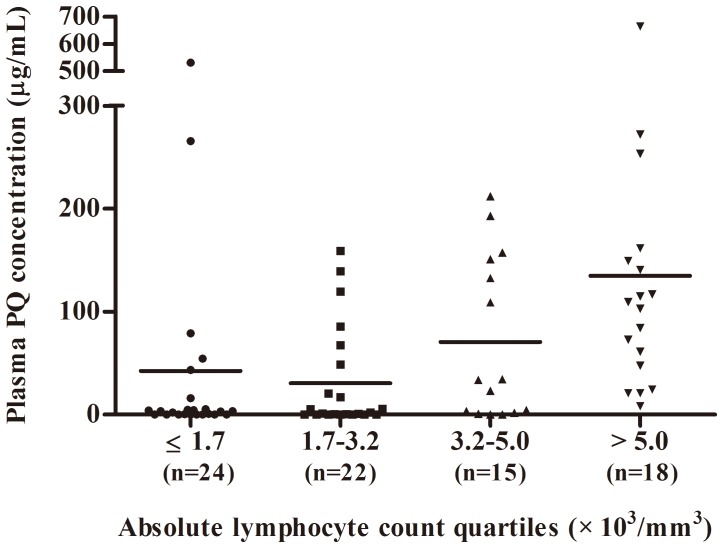
Scatter plot of plasma PQ concentration with line at mean in the absolute lymphocyte count quartiles.